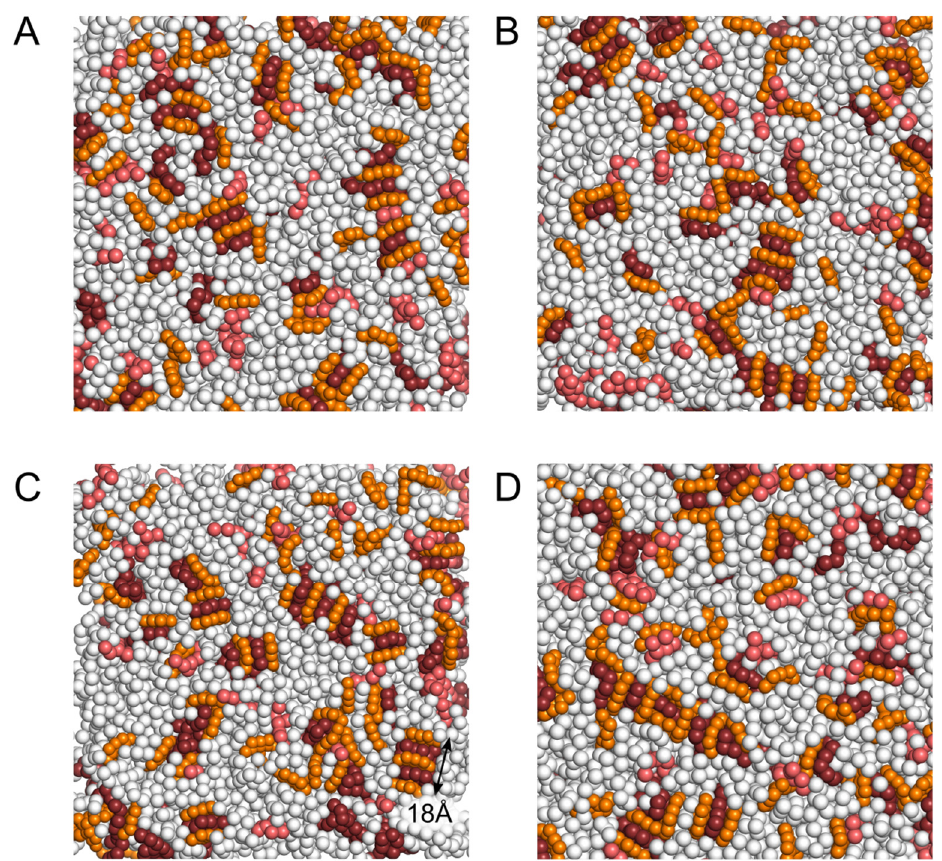
Figure 8. Snapshots demonstrating formation of heterogeneous stacks composed of NAO and ani- onic lipids when NAO is added to the membrane in the ratio of 1:6 NAO:lipid. PE is colored in white, PG—in salmon, CL—in dark ruby, NAO—in orange. Panels ( A – D ) correspond to different MD snapshots. Black double end arrow indicates the size of 3NAO:2CL heterogeneous stack.